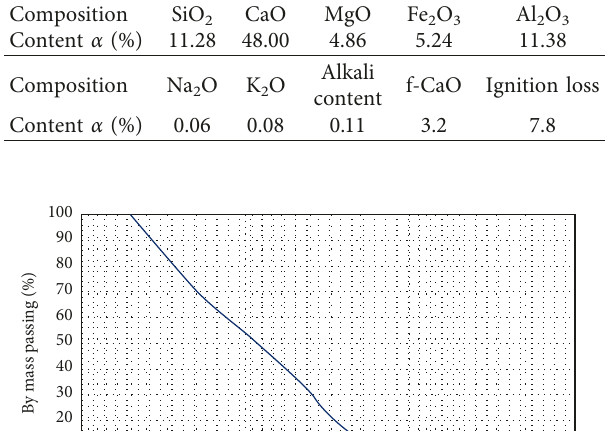
Table 1: Chemical composition of waste steel slag in the test.